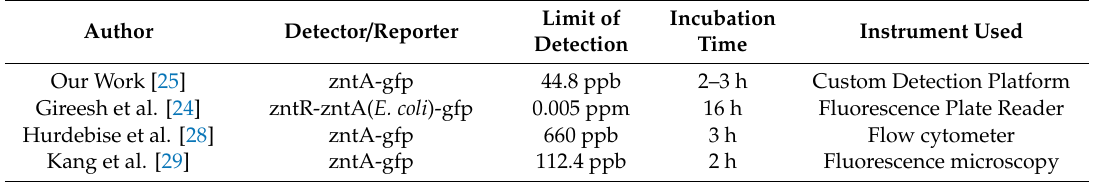
Table 1. Comparison of Previous Cadmium whole-cell